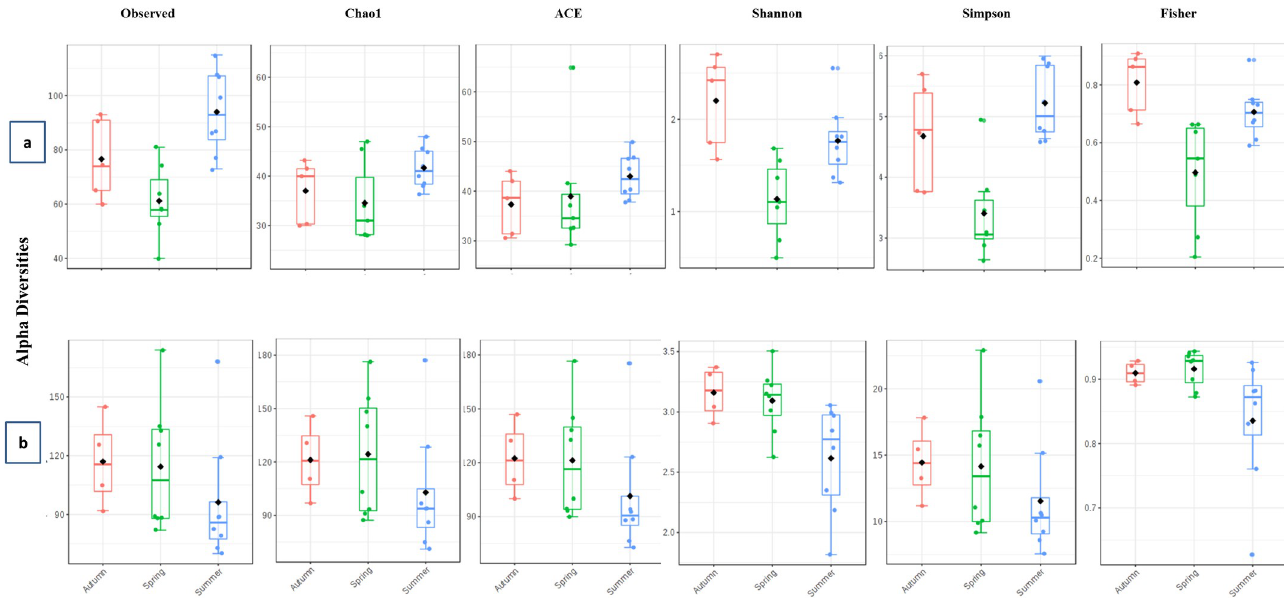
Fig 7. Season wise alpha diversity plots of (a) bacterial and (b) fungal communities. All comparisons were made through analysis of variance (ANOVA). Observed alpha diversity estimates are based on unique taxon richness or counts in each sample; Chao1 and ACE diversities are based on low abundance taxon richness; Shannon, Simpson and Fisher estimates are based on both taxon evenness (distribution) as well as richness.